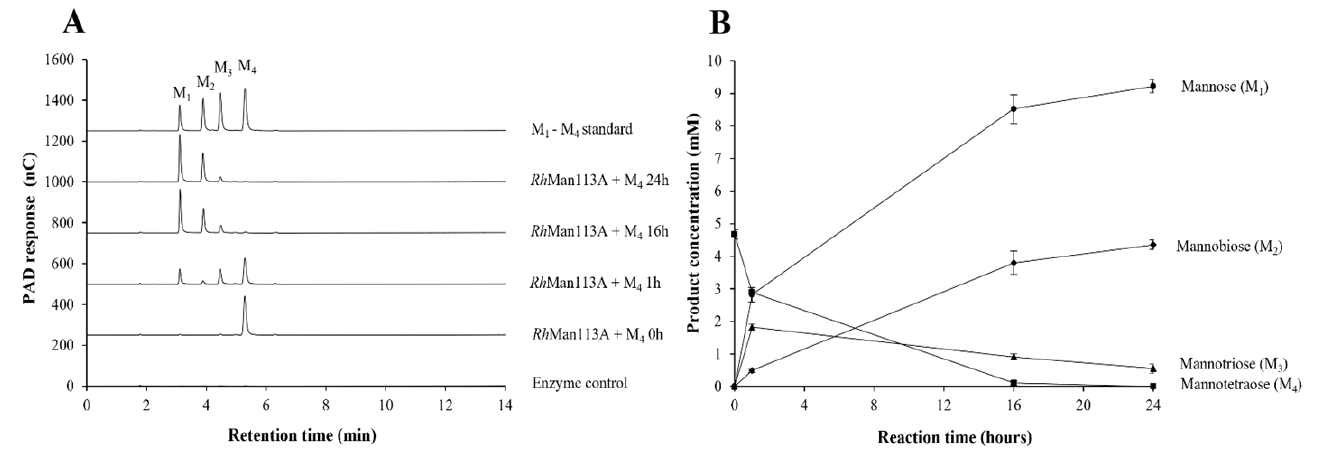
Figure 5. Progression of mannotetraose (M4) hydrolysis catalyzed by Rh Man113A. Rh Man113A (5 µg/mL) was incubated with 5 mM M4 at 30 °C in 50 mM sodium phosphate buffer (pH 6.0). ( A ) HPEAC–PAD analysis of hydrolysis reactions sampled over time. Mannose (M1) and mannan-oligosaccharides mannobiose to mannotetraose (M2–M4) were used as standards. ( B ) Profile of generated and consumed reaction products by Rh Man113A over time. Data from triplicate incubations and mean values ± SD (standard deviation) are presented. Table 2. Specific activity and enzyme kinetic parameters of Rh Man113A, using different substrates. Rh Man113A